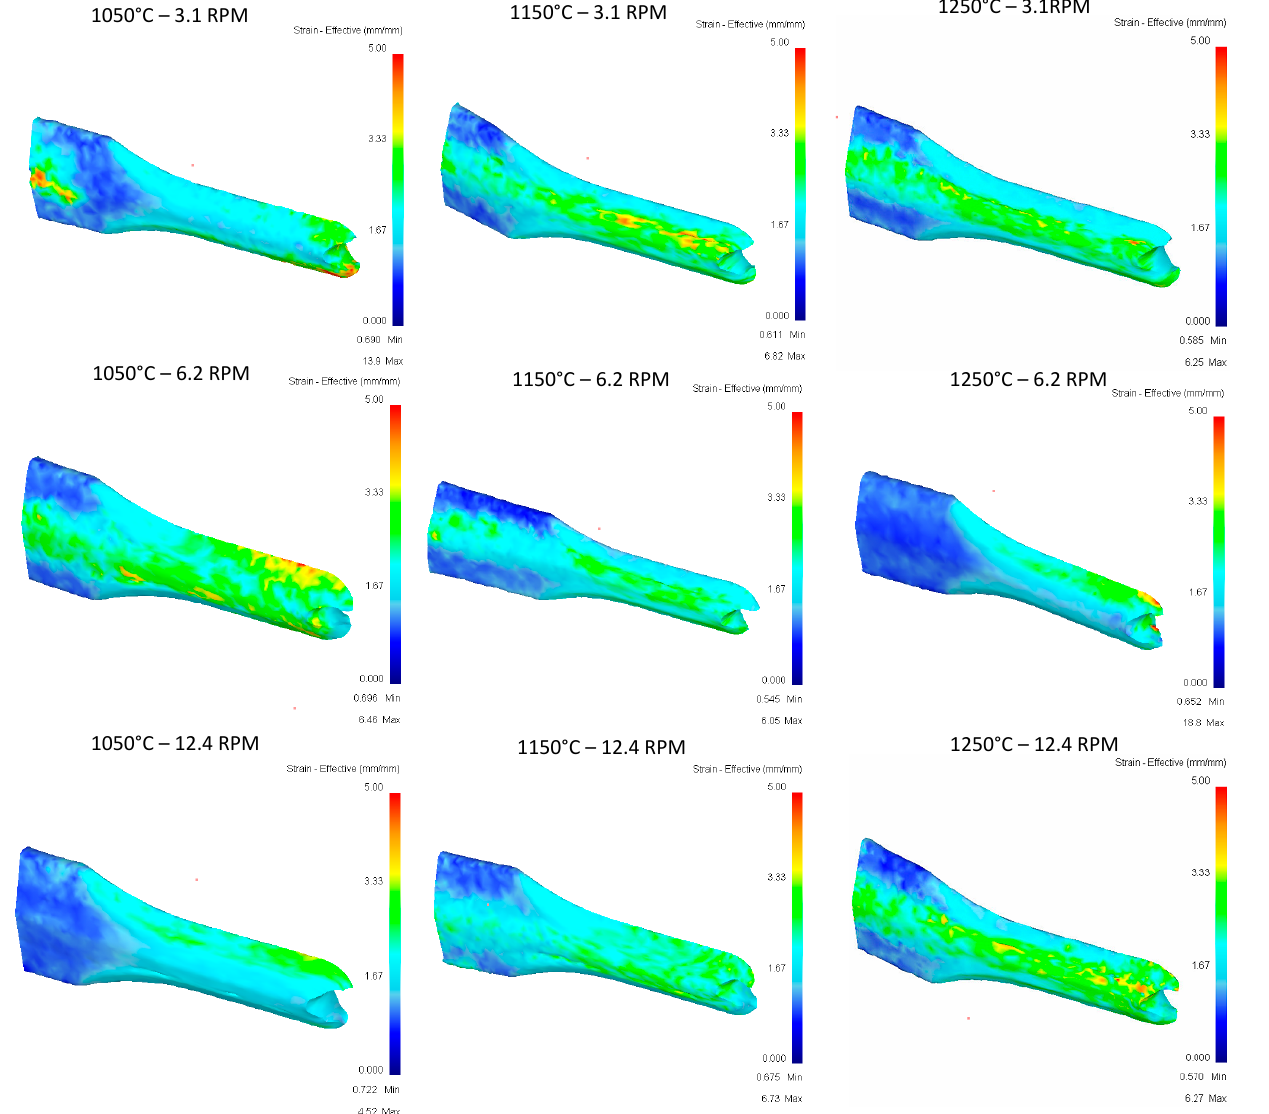
Figure 17. Effective Stress in the top Rail after third pass. Figure 18 shows the temperature graph obtained for the tirth pass for all the different scenarios of this work.